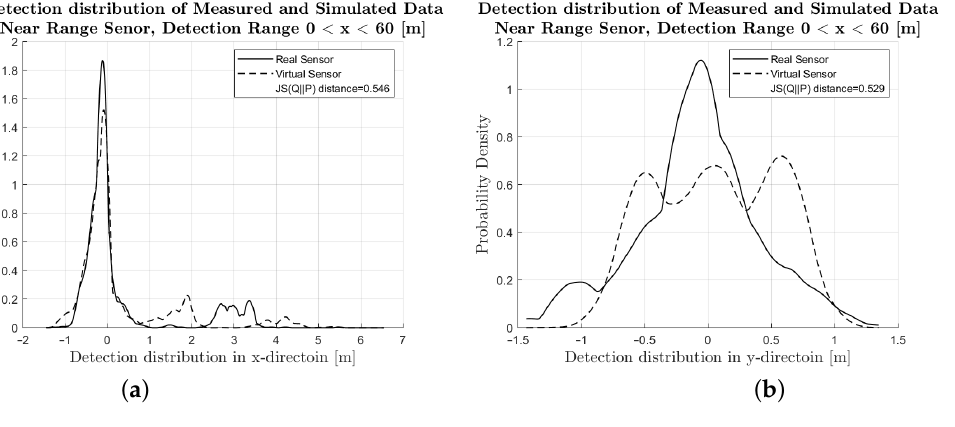
Figure 8. Evaluation of the detections in the range of 0 to 60 m of the near-range radar sensor and sensor model. ( a ) PDF of the deviation in the x -direction from P ref ( x , y ) of the real sensor and sensor model. ( b ) PDF of the deviation in the y -direction from P ref ( x , y ) of the real sensor and sensor